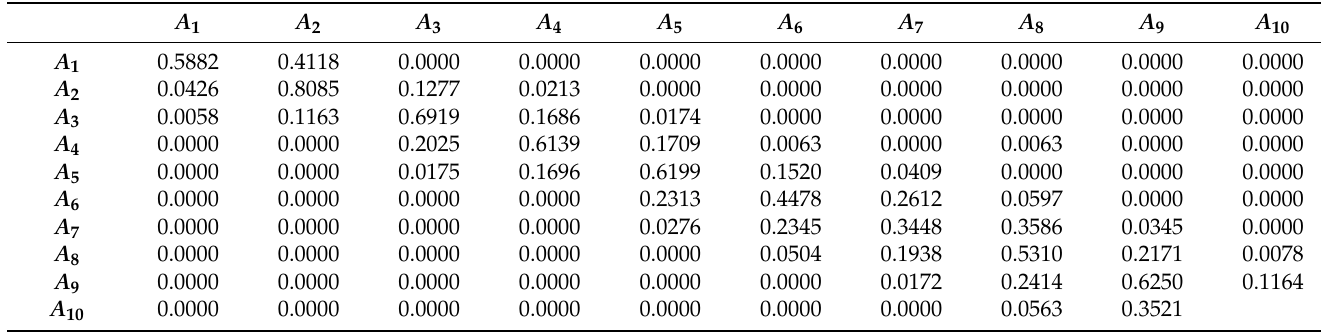
Table 5. The standardized weight